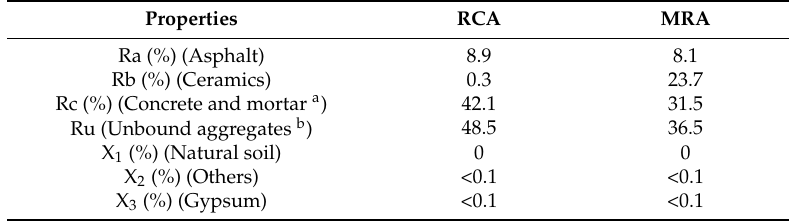
Table 2. Composition of recycled aggregates evaluated according to